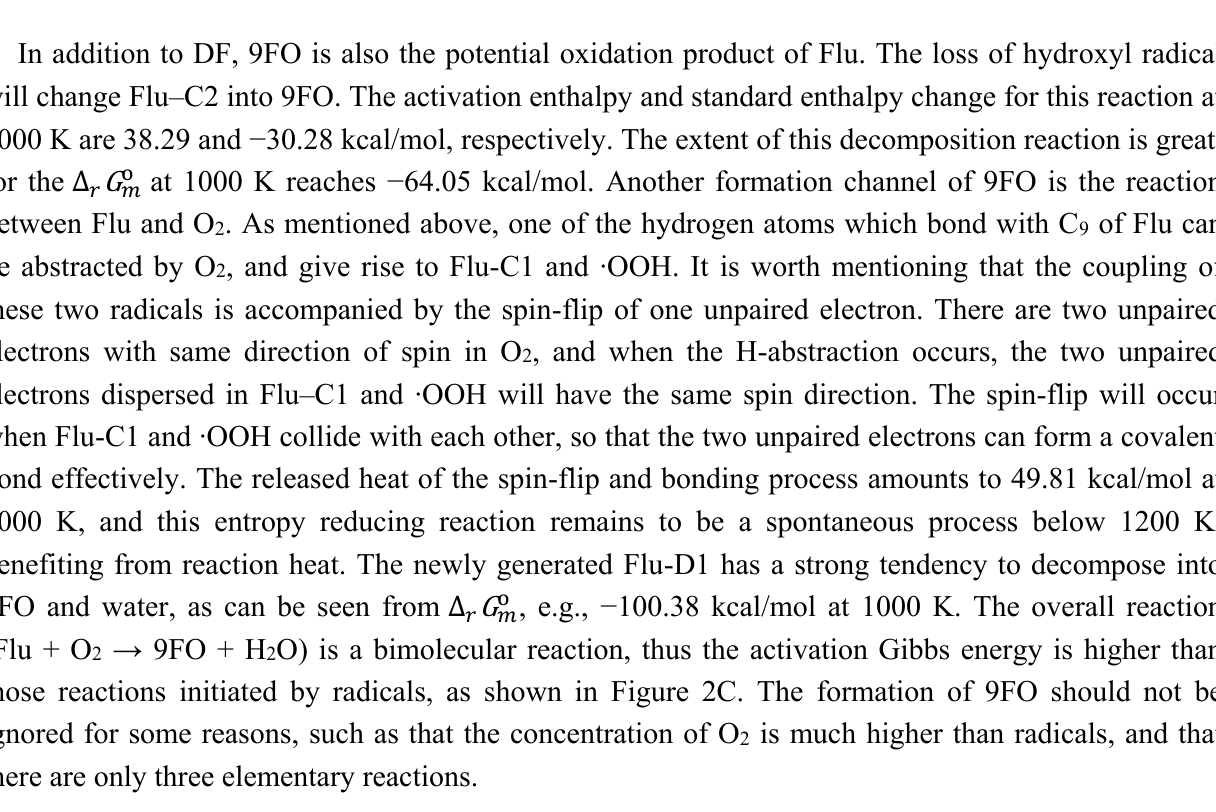
Table 1. Comparison of the C 9 -H abstraction reactions at 1000 K (energy unit is kcal/mol). H-Abstraction